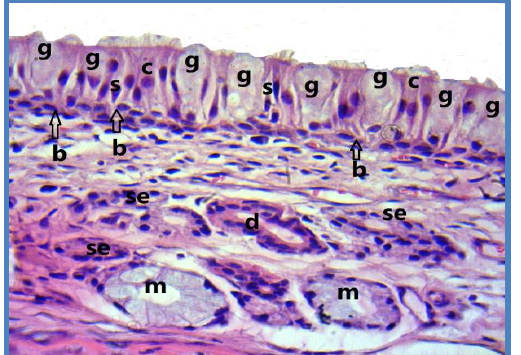
Figure(7): Histological section of nasal cavity(nasal septum) showing: (AB+) goblet cell and respiratory glands (AlcianblueX 40).